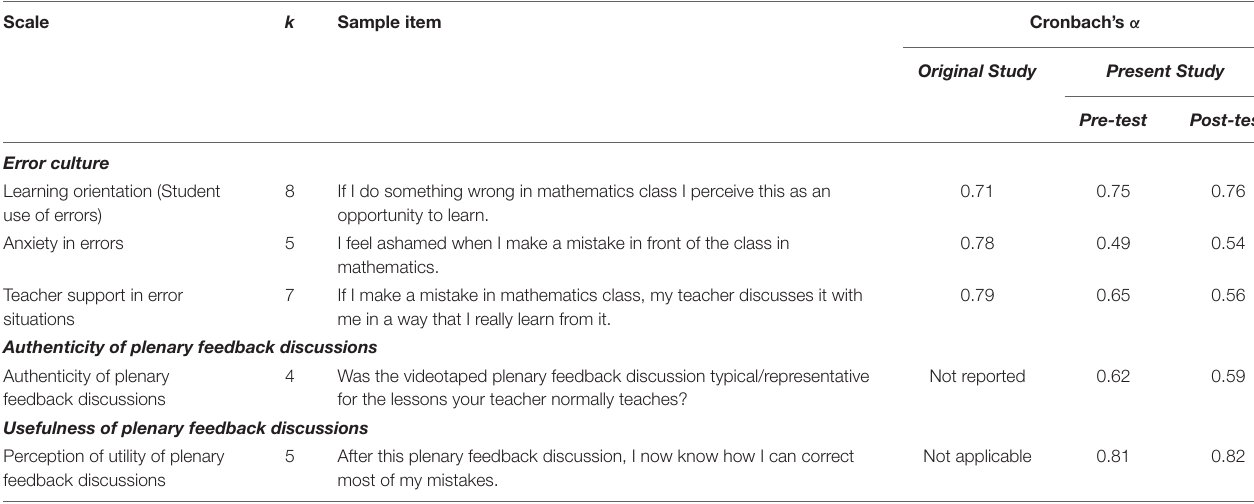
TABLE 2 | Scales, sample items and Cronbach’s α